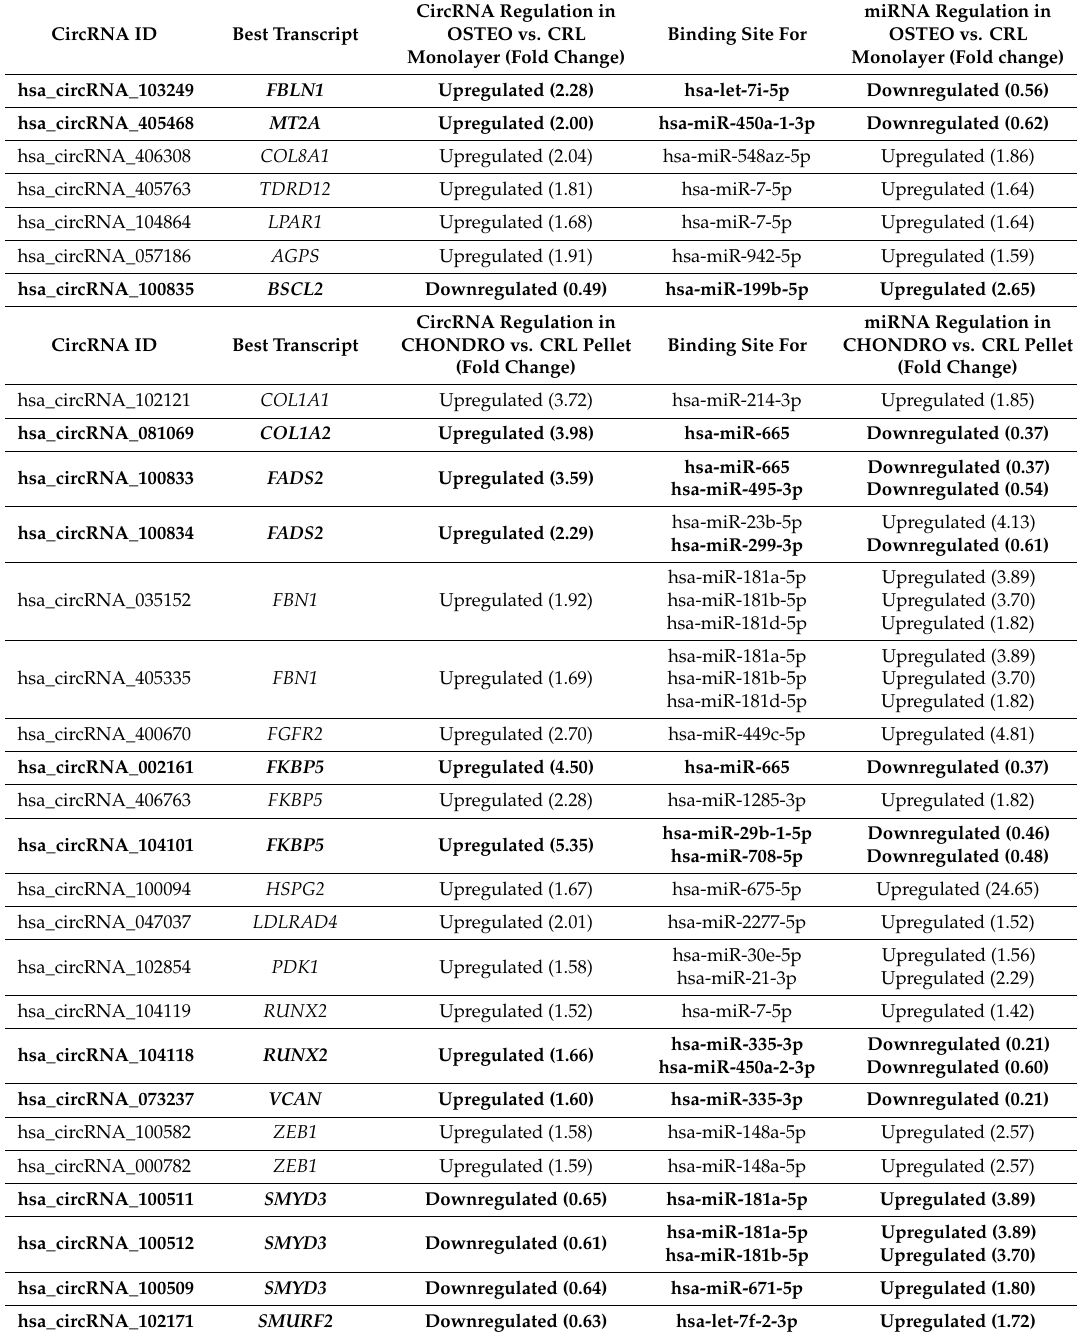
Table 3. Comparison between miRNA-binding sites of di ff erentially expressed circRNA with the list of di ff erentially expressed miRNAs in osteogenic di ff erentiation. The pairs that presented an opposite direction of regulation are highlighted in